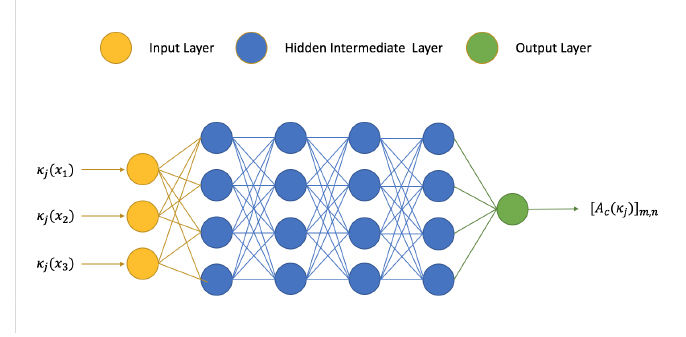
Figure 4. An illustration of a deep neural